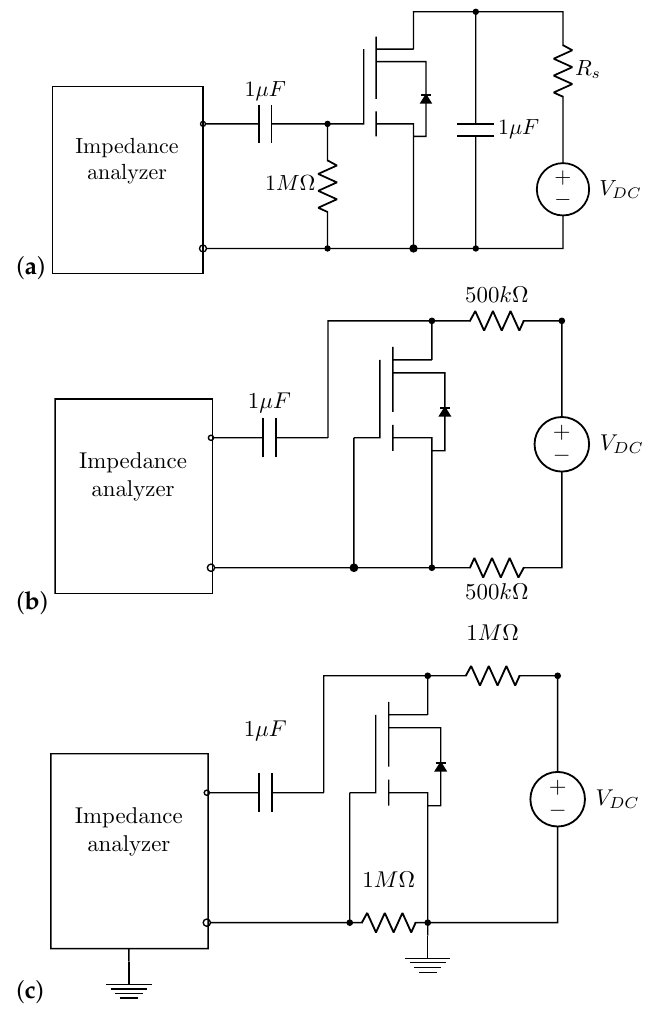
Figure 3. Schematics of dedicated circuits for transistor capacitances measurement: ( a ) C ISS , ( b ) C OSS , and ( c ) C RSS